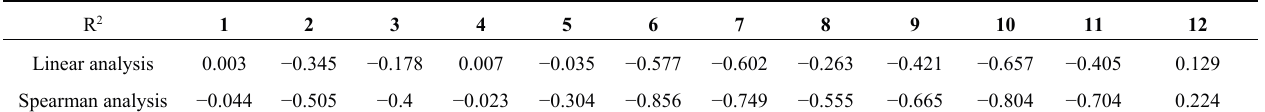
Table 2. Correlation between PM 2.5 and humidity in a